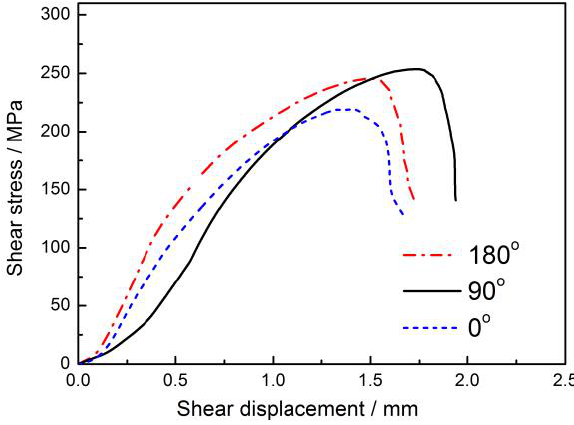
Figure 11. Shear stress-displacement curves acquired from the compression-shear tests.